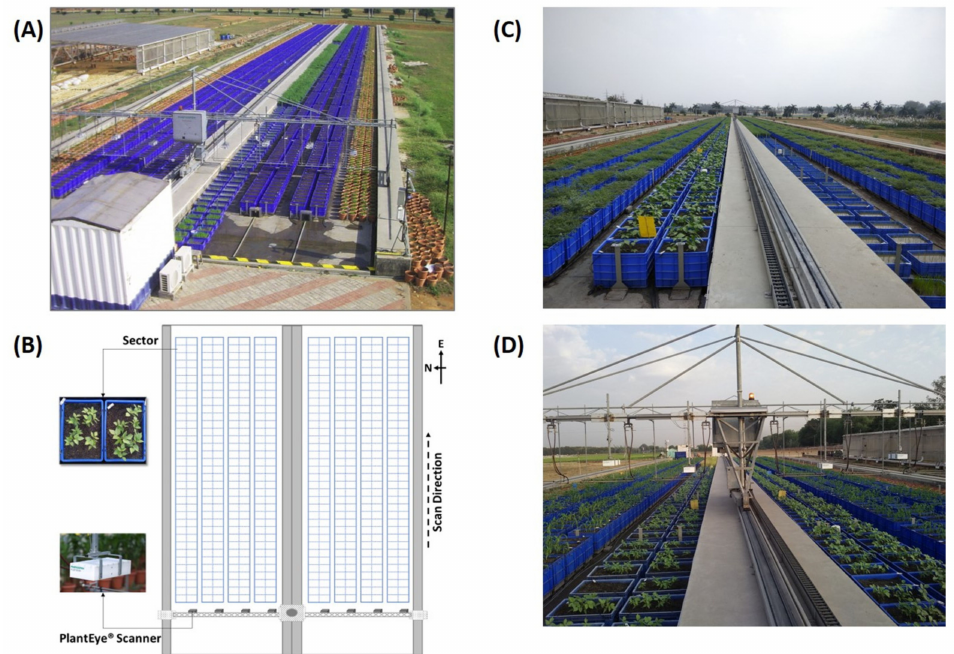
Figure 1. ( A ) Aerial view of LeasyScan high-throughput plant phenotyping facility at ICRISAT; ( B ) Layout of the platform showing sectors and PlantEye ® laser scanners that generate a digital reflection of plants in the form of 3D point clouds; and ( C , D ) Mung bean and chickpea genotypes monitored continuously for crop canopy